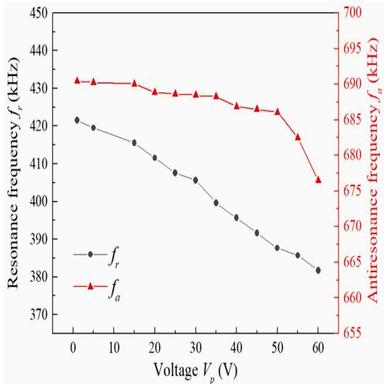
The thickness-mode resonance and antiresonance frequencies of the PMN-PT composite disk as a function of the AC driving voltage.